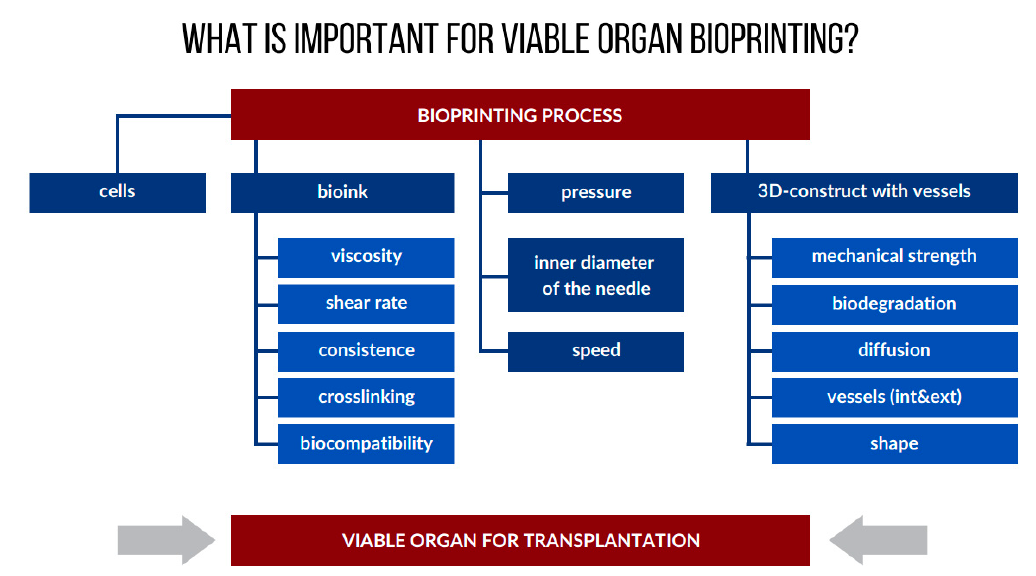
Figure 4. What is important for viable organ bioprinting? Parameters are based on the most